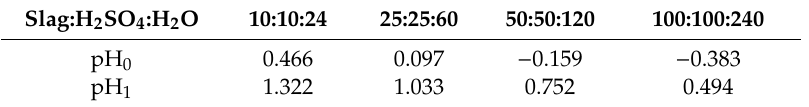
Table 8. pH values of solutions at the beginning and after the end of DD mixture water